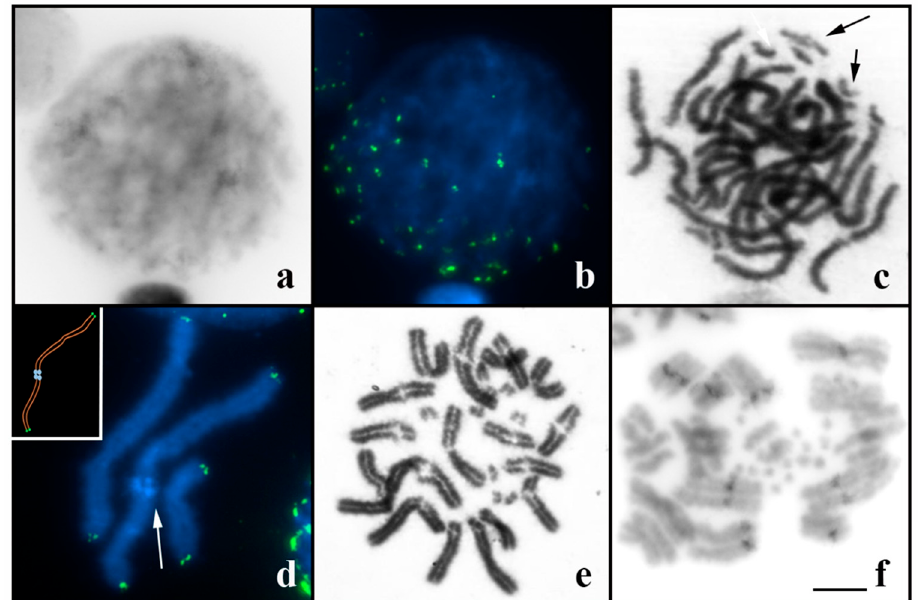
Figure 4. Meiotic behavior in N. parvulus : ( a ) Zygotene. ( b ) The same nucleus in “a” subjected to FISH with a telomere probe; note the polarized arrangement of the telomeres. ( c ) Pachytene; arrows indicate microbivalents. ( d ) Isolated pachytene bivalents; the arrow indicates heterochromatic domains in the pericentromeric region. The insert shows a schematic representation of the bivalent indicated by the arrow. ( e ) Post ‐ pachytene. ( f ) Anaphase I. Bar = 10 μ m.